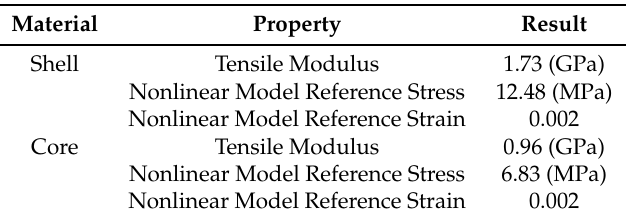
Table 3. Material inputs for the non-linear FEA